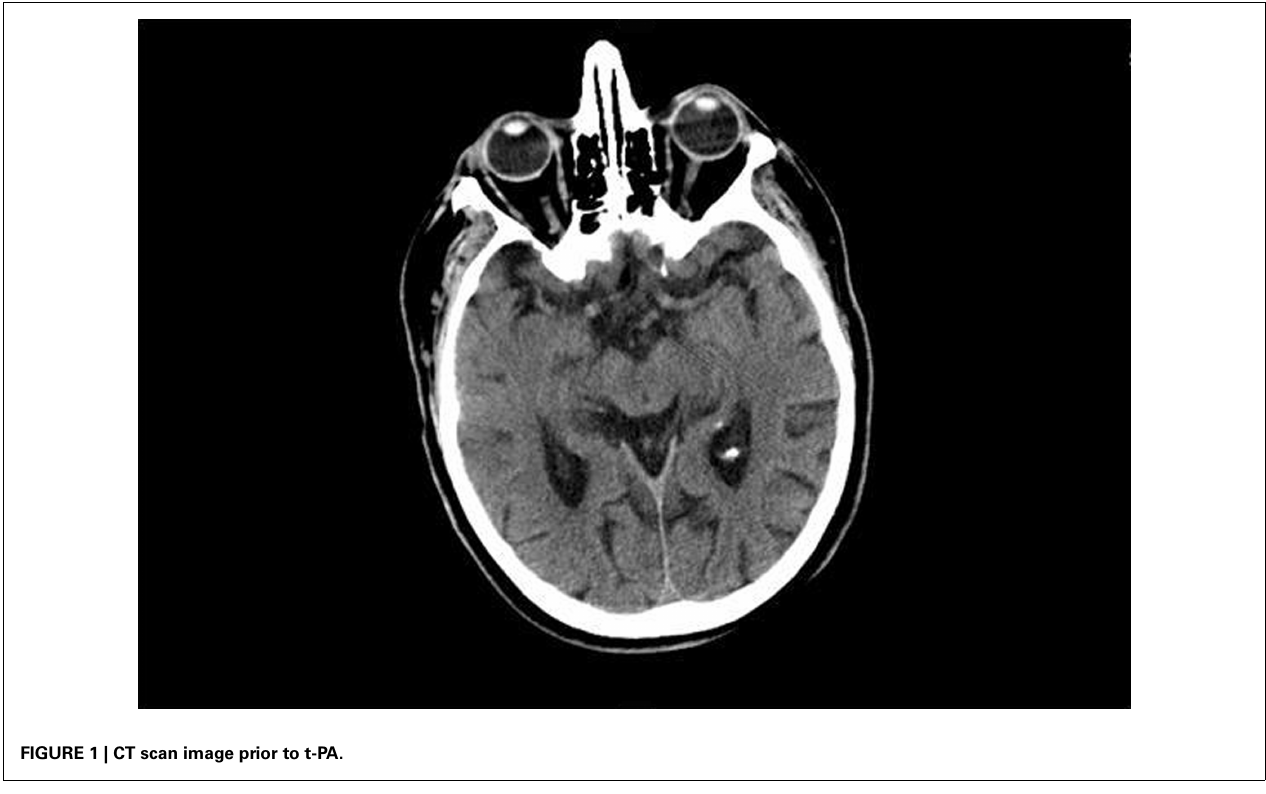
FIGURE 1 | CTscan image prior to t-PA.